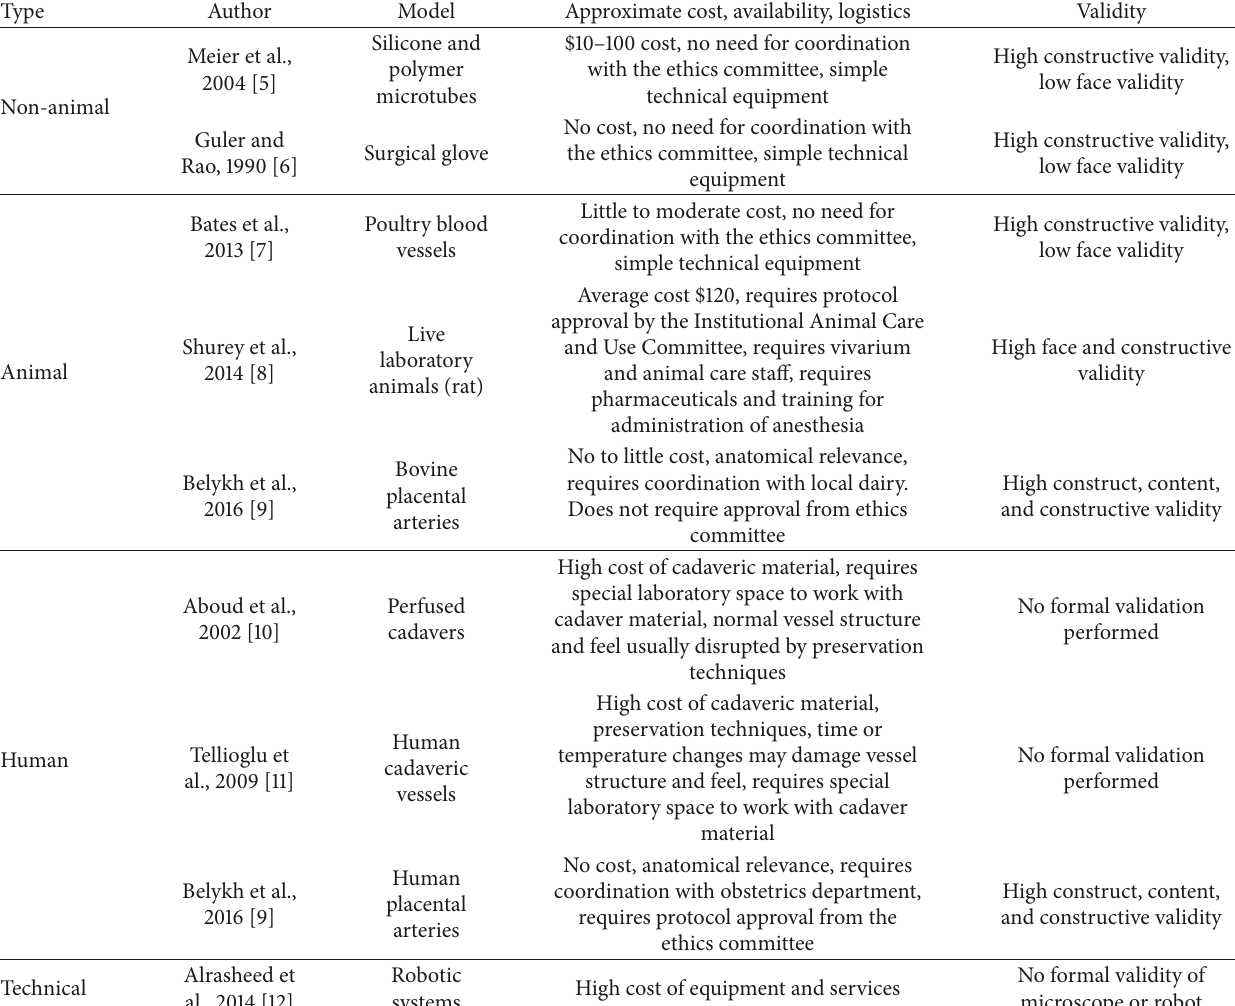
Table 1: Validated models for microvascular anastomosis